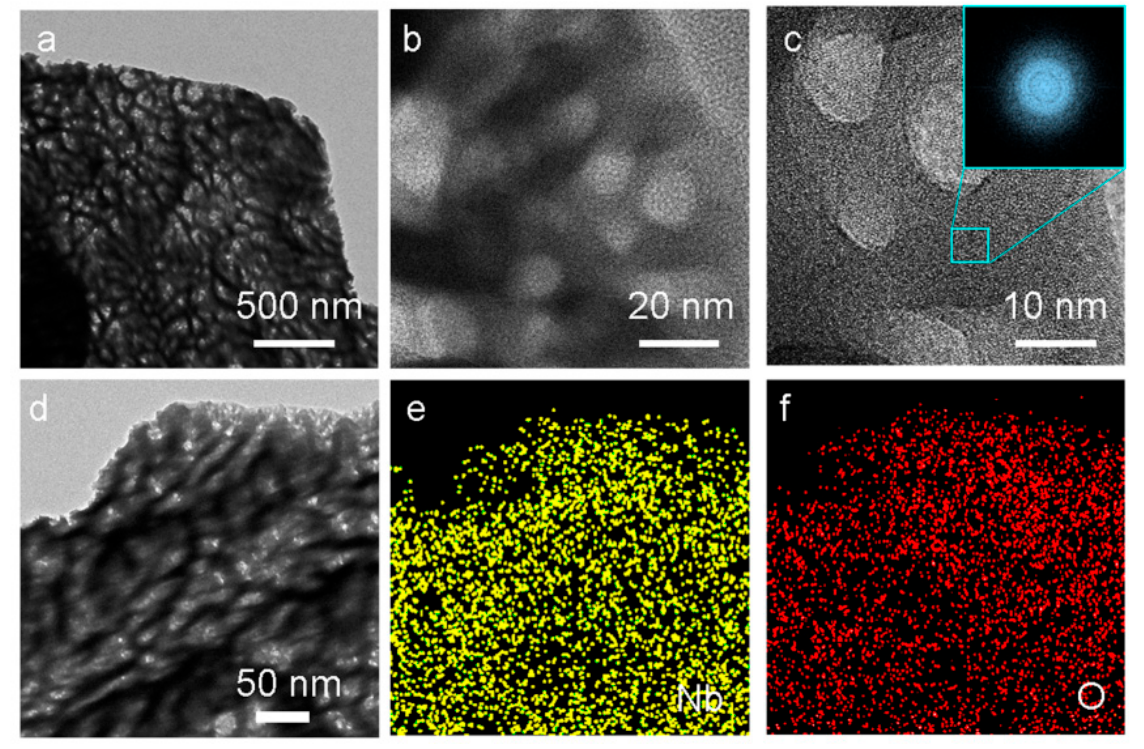
Figure 2. ( a , b ) TEM images. ( c ) HRTEM image from the selected area. Inset: fast Fourier transform (FFT) images for framed areas. ( d – f ) TEM images and elemental mapping images of the P-Nb 2 O 5 .